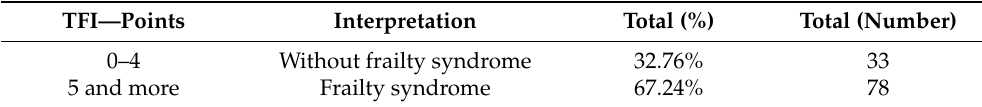
Table 4. Analysis of the occurrence of frailty syndrome (TFI